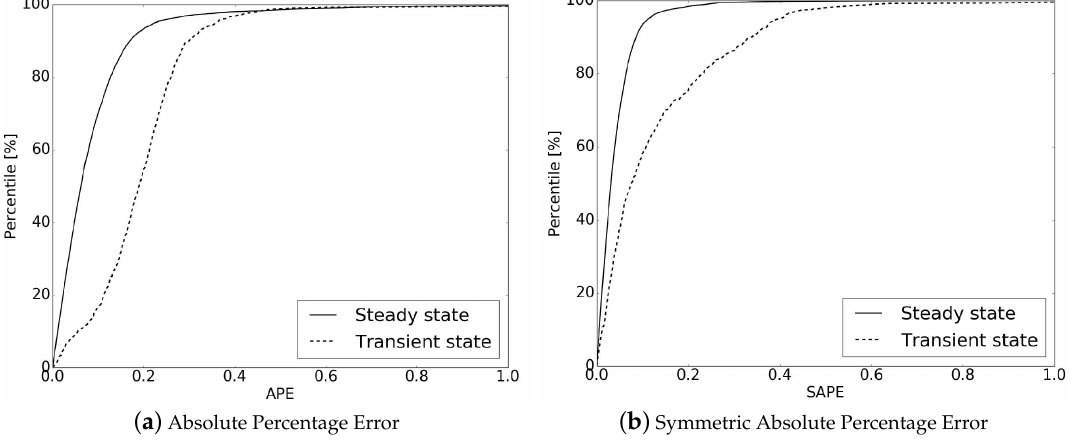
Figure 9. Percentile distribution of APE and SAPE over the whole season for a single-cycle